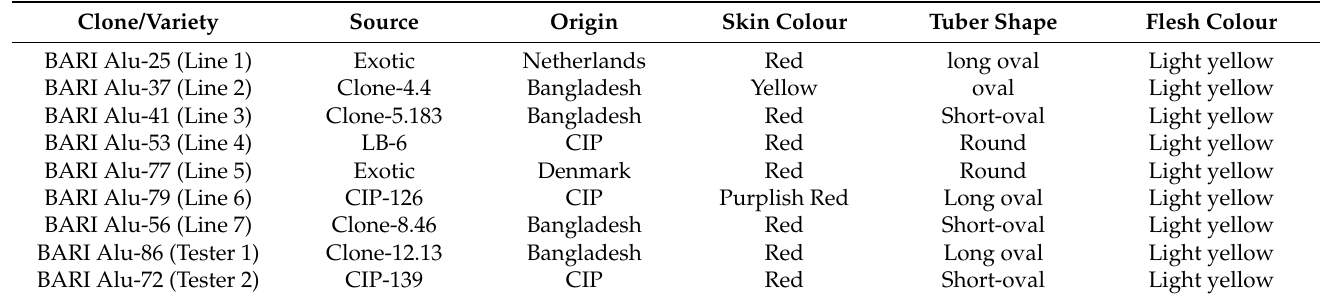
Table 1. Pedigree and characteristics of male and female parents used in this LXT